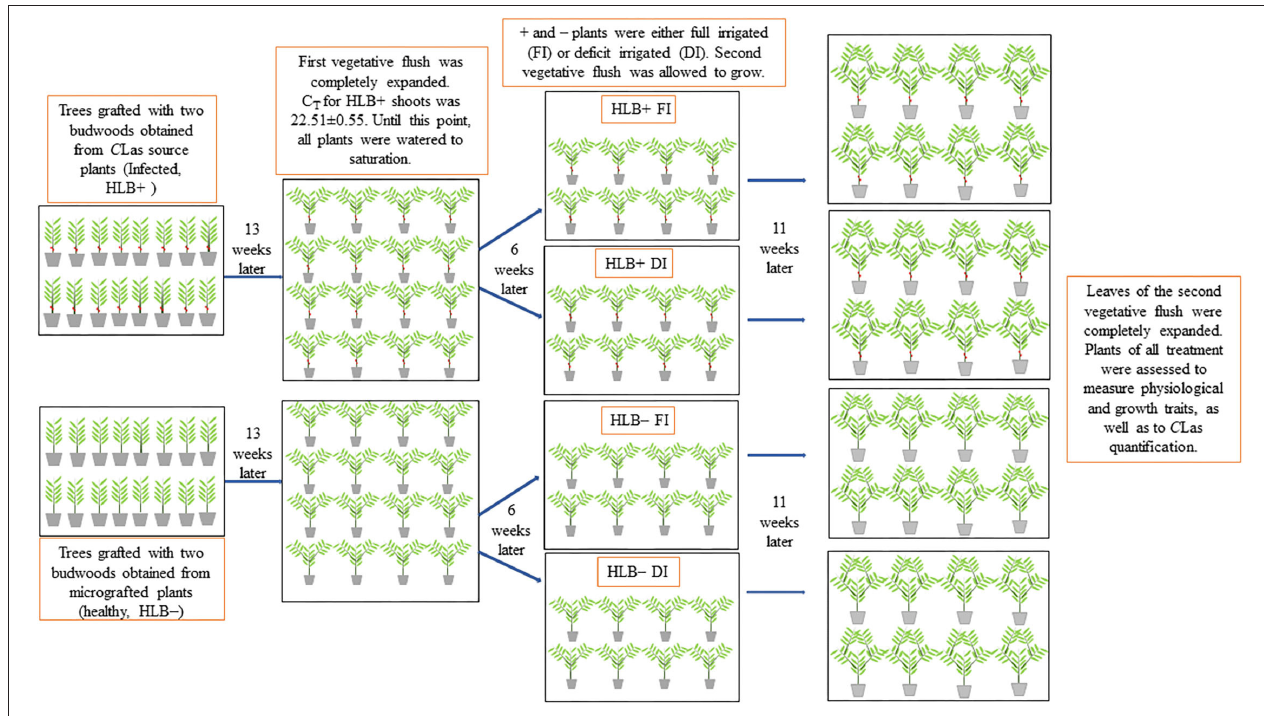
FIGURE 1 | Schematic representation of the experiment. Young citrus trees were separated into two groups and either (i) bud grafted with two buds obtained from micrografted plants (healthy, –) or (ii) bud grafted with two budwoods obtained from C Las source plants (infected plants, + ). Two branches were allowed to grow per plant (first vegetative flush). Thirteen weeks later, the first vegetative flush was completely expanded, and HLB + shoots presented a cycle threshold value (C T ) of ca. 22.5. Six-weeks later, half of the trees were fully irrigated (FI) to saturation, and the other half were deficit-irrigated (DI) using 40% of the water required to saturate the substrate. Thereafter, the second vegetative flush was allowed to grow for 11 weeks. At this point, plants of all the treatments were assessed to measure physiological and growth traits and quantify C